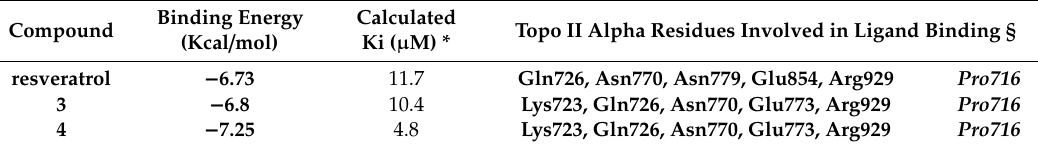
Figure 5. Binding modes of compounds evaluated to topoisomerase II. The protein is represented as cyan ribbons, amino acids involved in the binding are evidenced as sticks and properly labelled. Panel ( A ), superposition of resveratrol, compounds 3 and 4 . Panel ( B ), resveratrol is drawn in orange. Panel ( C ), compound 3 is shown as violet sticks. Panel ( D ), compound 4 is drawn as light green stick. Table 3. Binding energies and residues involved in the interaction between topoisomerase II and compounds